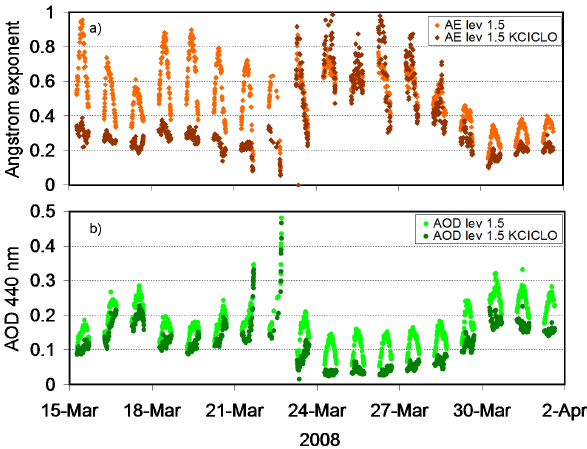
Figure 1. (a) AE in the range 440–870nm and (b) AOD at 440nm shown with and without the KCICLO correction from 15 March to 1 April 2008 (refer to legend for colour description). Two different corrections were applied before and after 23 March. AE and AOD are dimensionless parameters. Table 1. Dimensionless mean K values and standard deviation (SD) for each channel and for each period of correction a .